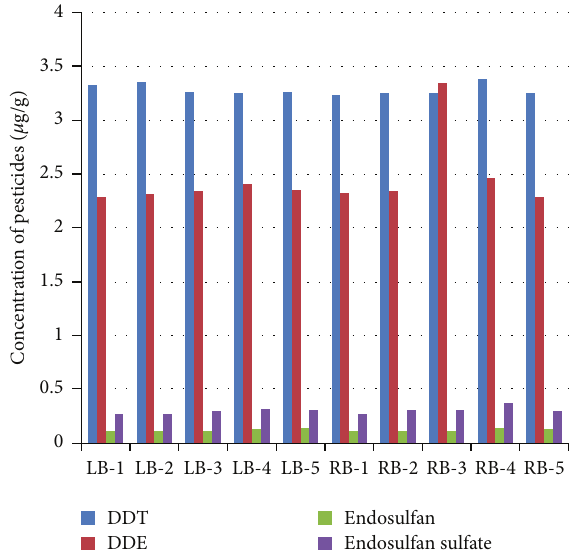
Figure 2: Comparison of different pesticides detected in fish muscle of Catla catla from ten different locations of Ravi river.